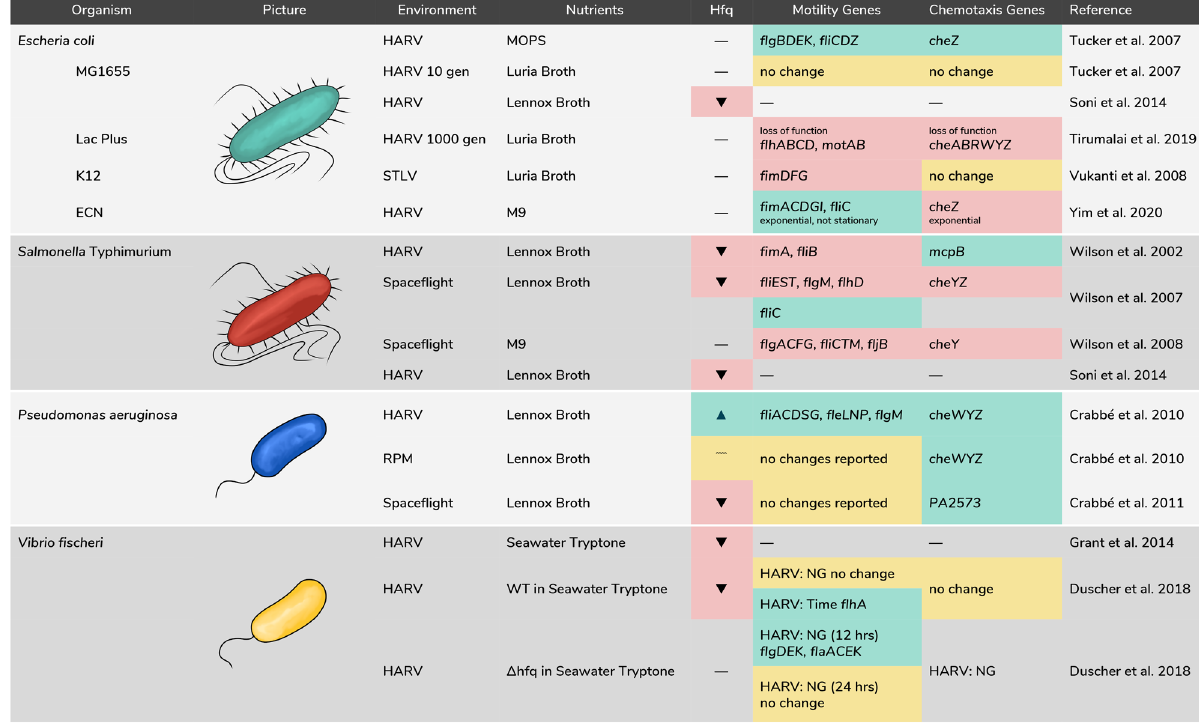
Fig. 5 Motility and chemotaxis gene expression categorized by study and organism. Color indicators: Green: upregulation, Yellow: no change reported, Red: downregulation. Dashes indicate no data available. Normal Gravity Rotation control is represented by